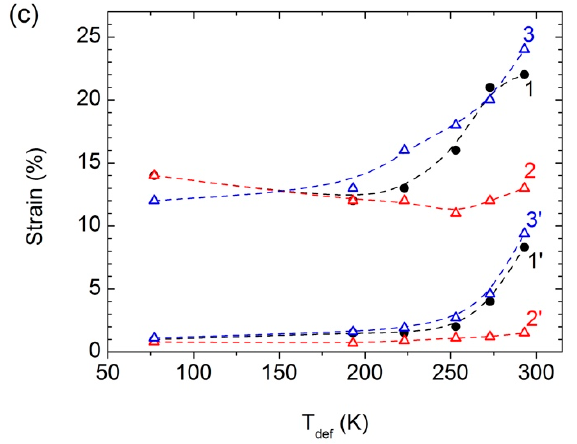
Figure 5. Dependence of mechanical properties—( a ) yield stress, ( b ) ultimate tensile strength, and ( c ) total (curves 1–3) and uniform (curves 1 ′ –3 ′ ) ductility—on the deformation temperature for the Al–0.4Zr alloy after HPT-processing (curves 1, 1 ′ ), after HPT-processing and subsequent annealing at 503 K for 1 h (curves 2, 2 ′ ), and after HPT-processing, annealing and additional HPT deformation to 0.25 revolutions (curves 3, 3 ′ ).